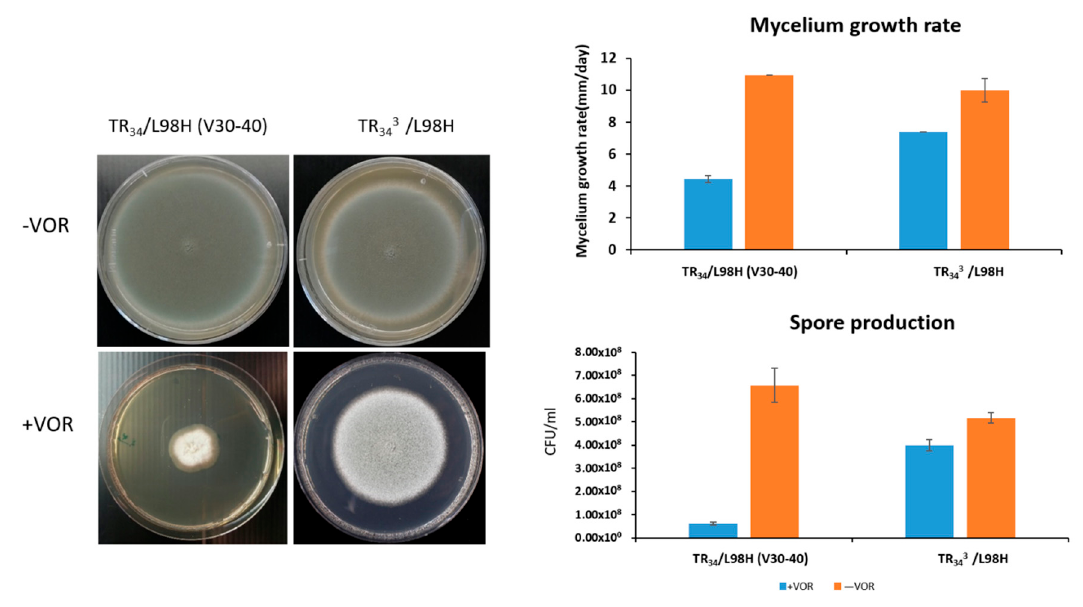
Figure 4. The growth characteristics of TR 34 /L98H and TR 343 /L98H, including the phenotype, growth rate and conidia production when cultured in the presence and absence of voriconazole (VOR) (2